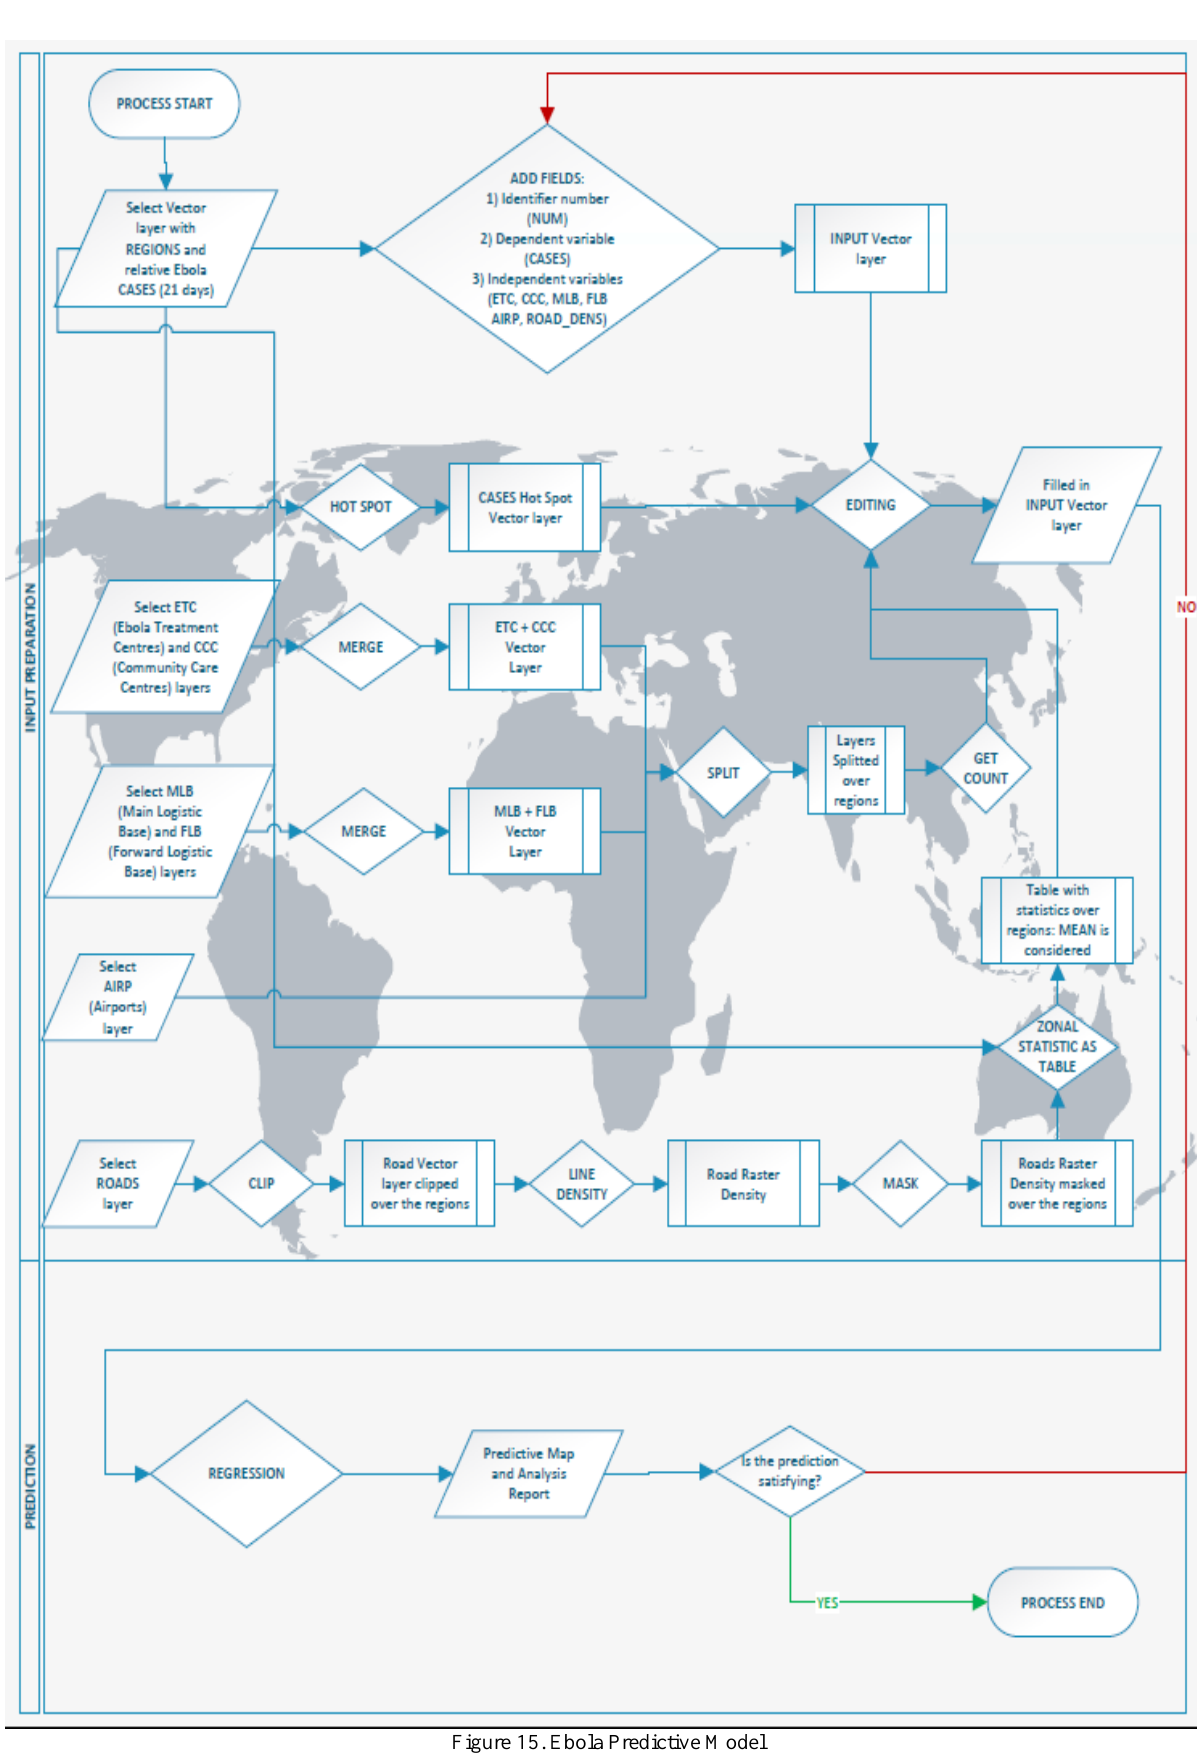
Figure 15. Ebola Predictive